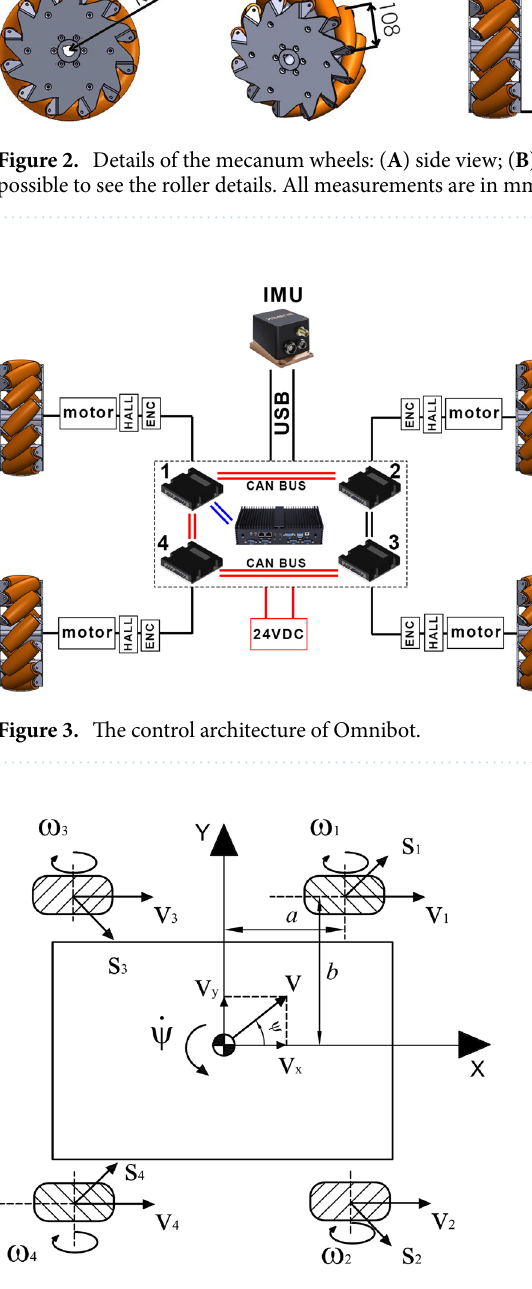
Figure 4. Movement vector and coordinate system of mobile four-wheel drive